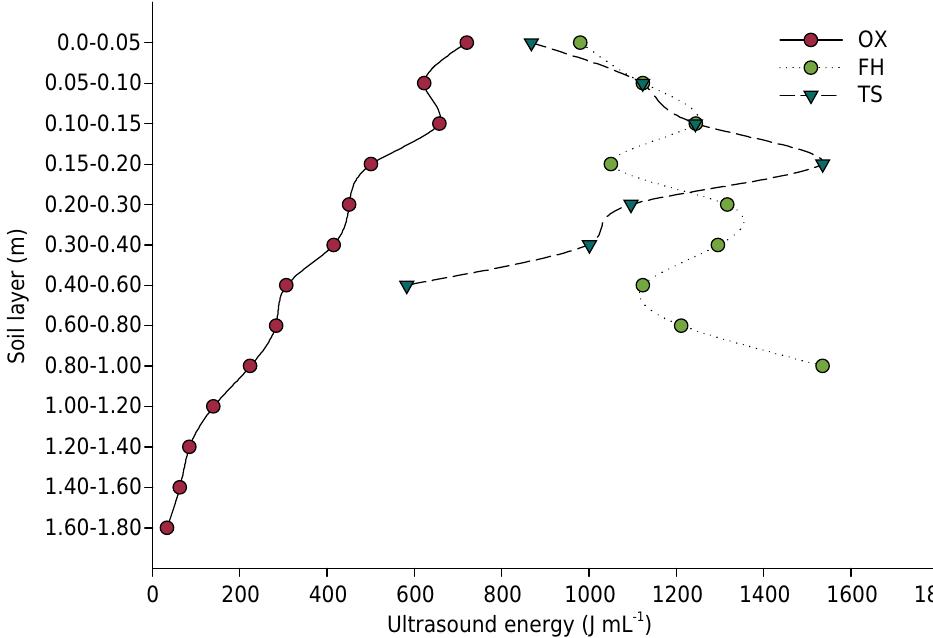
Figure 4. Energy levels for clay dispersion in samples from three different soils along a toposequence in Araucaria moist